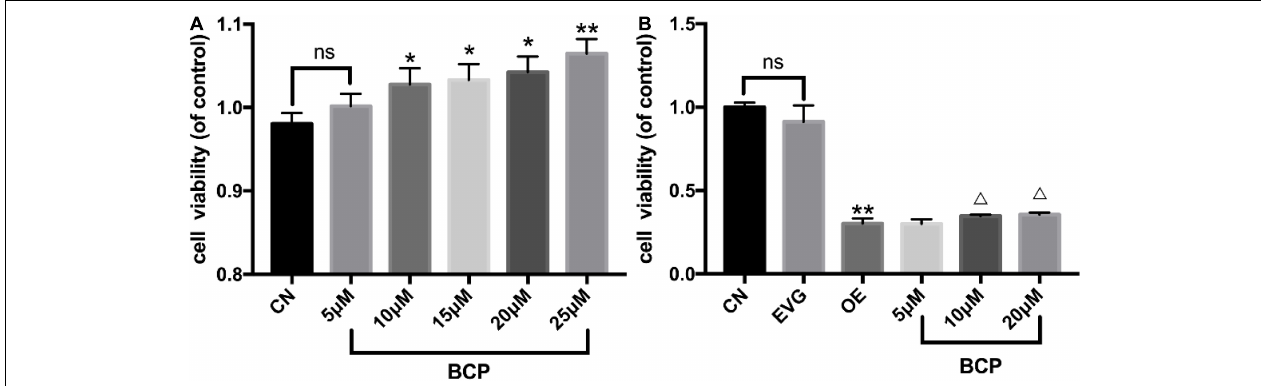
FIGURE 2 | Effect of different doses of BCP on the viability of PC-12 cells. CN denotes the control group without special treatment; EVG denotes the empty vector group in which the PC-12 cells were transfected with plasmid vectors without gene fragments; OE means the group in which the PC-12 cells were transfected with human APP plasmid; and BCP denotes the group in which the PC-12 cells were transfected for 48 h and then incubated with different concentrations of BCP for 24 h. (A) Effects of different concentrations of BCP on the viability of PC-12 cells for 24 h. (B) After 48 h of transfection, the effect of BCP on the viability of PC-12 cells for 24 h. Compared with CN, ns p > 0.05. Compared with EVG, * p < 0.05, ** p < 0.01. Compared with OE group, (cid:49) p < 0.05, (cid:49)(cid:49) p < 0.01. One-way ANOVA with Bonferroni’s post hoc test.